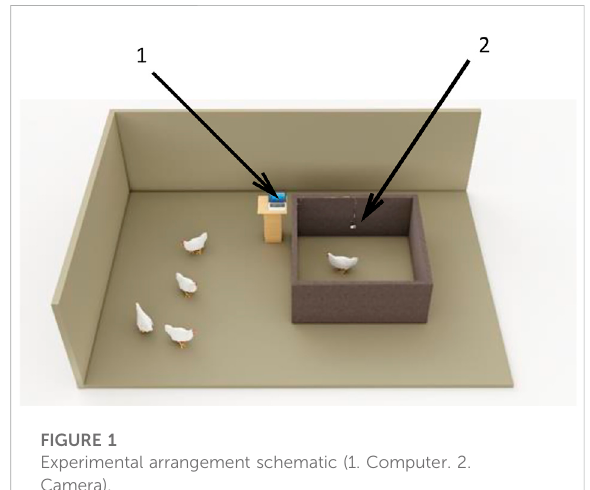
FIGURE 1 Experimental arrangement schematic (1. Computer.